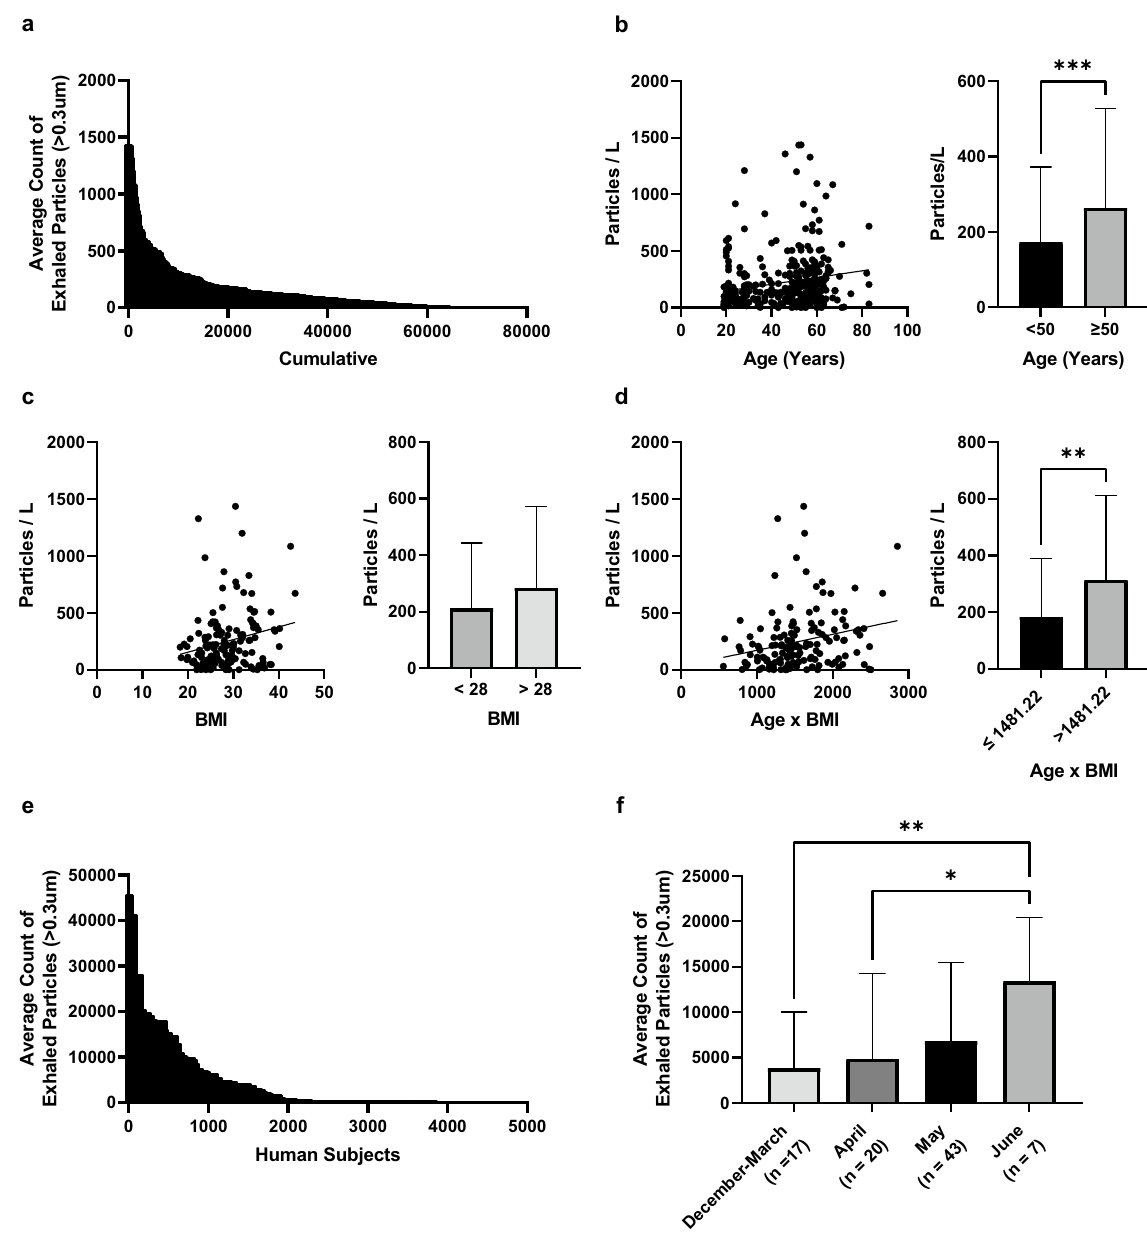
Figure 2. Exhaled aerosol particle numbers among healthy and infected human subjects in Germany and India following normal tidal breathing. ( A ) Exhaled aerosol particle numbers for 357 healthy human subjects in Marburg Germany. ( B ) Exhaled aerosol particle numbers versus age, with median = 50 years. ( C ) Exhaled aerosol particle numbers versus BMI, with median = 28. ( D ) Exhaled aerosol particle numbers versus BMI-age, with median = 1481.22. ( E ) Exhaled aerosol particle numbers from 87 mildly symptomatic COVID-19 subjects. ( F ) Mean exhaled aerosol numbers for the 87 COVID-19 patients as a function of time period of infection and recruitment. Error bars represent standard errors of the mean. *P < 0.05, **P < 0.005, ***P <